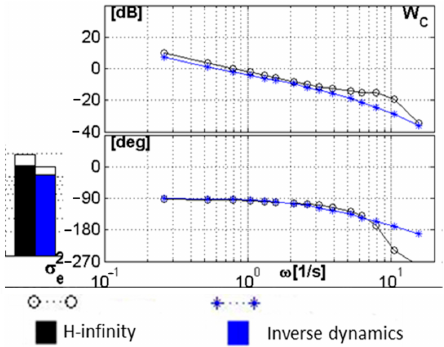
Figure 11. Inverse dynamics vs. H-infinity with actuator constraints and low gain.